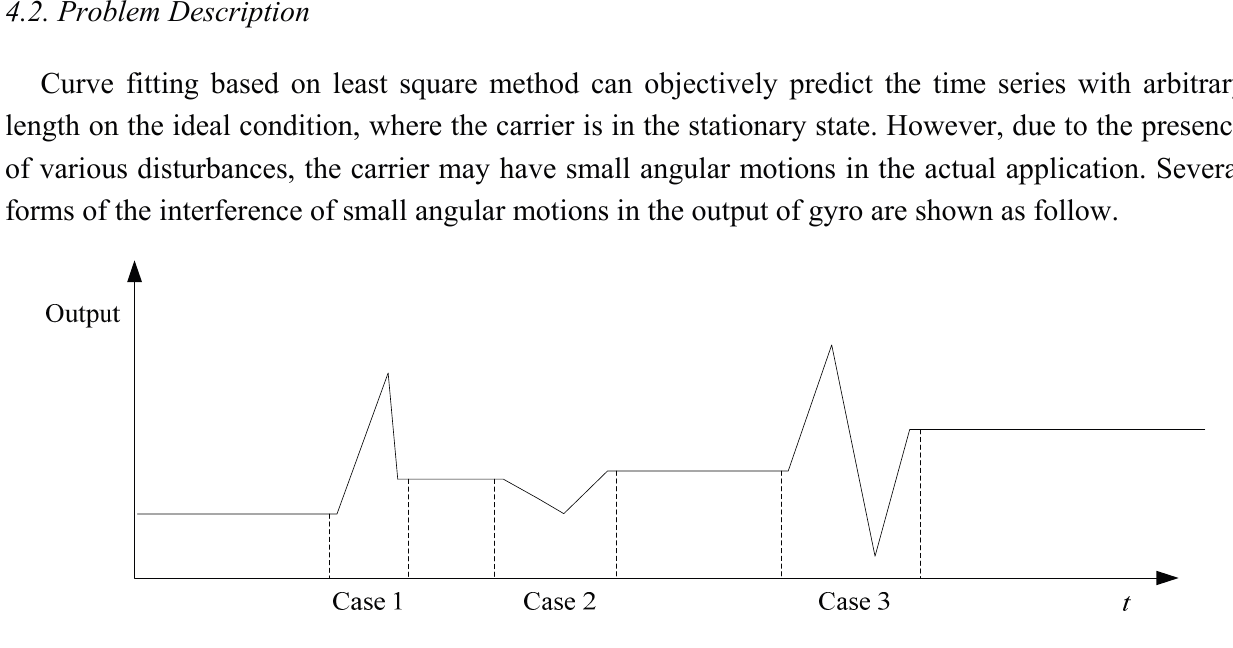
Figure 3. Several forms of the interference of small angular motions in the output of gyro. Case 1: IMU moves by a small angular along positive direction (clockwise); Case 2: IMU moves by a small angular along negative direction (anti-clockwise); Case 3: IMU moves by a small angular along positive direction and then moves along negative